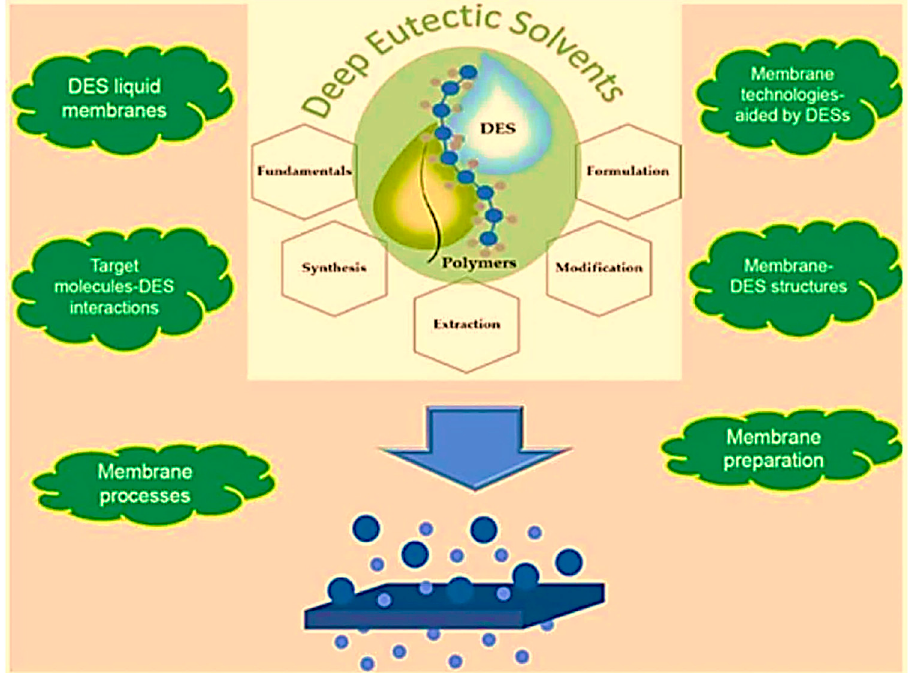
Figure 13. Applications of DESs in various processes in membrane technology [69].